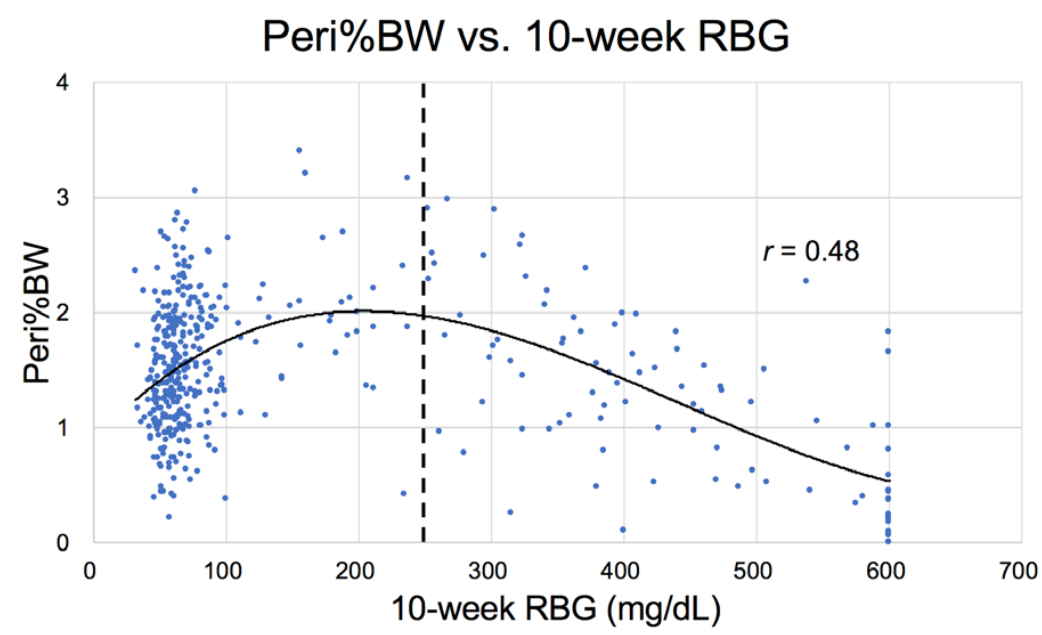
Figure 12. Perirenal fat pad % body weight (Peri%BW) plotted against random blood glucose ( n = 439). The vertical bar suggests that fat loss begins sooner in this tissue mass, i.e., when RBG rises above 250 mg/dL.